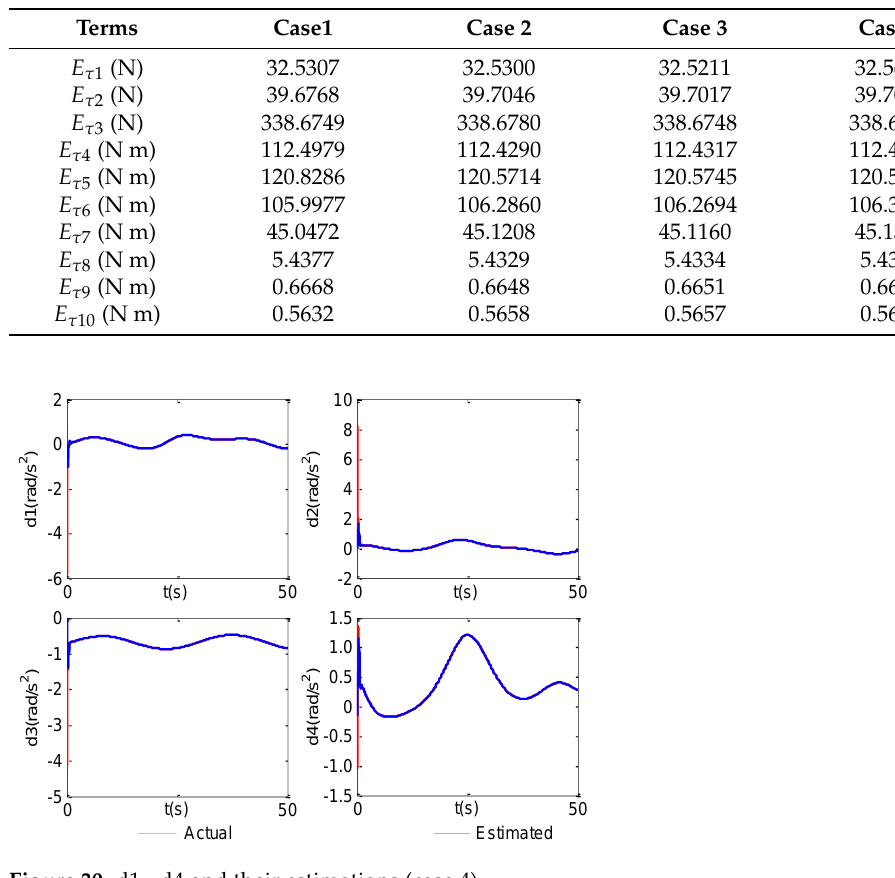
Figure 30. d1 − d4 and their estimations (case 4).